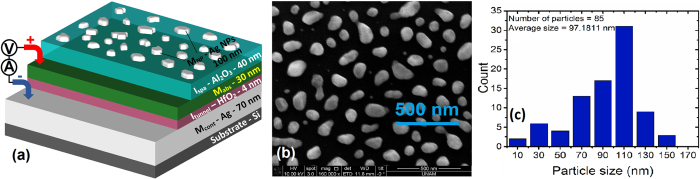
(a) Schematic of the MIMIM device, comprised of metal nanoparticles (MNP), spacer insulator (Ispa), absorbing metal (Mabs), tunneling insulator (Itunnel) and bottom contact metal (Mcont), (b) SEM image of the nanoparticles after annealing 10 nm Silver film for 20 min at 500 °C and (c) the size distribution of particles from SEM image of part (b).